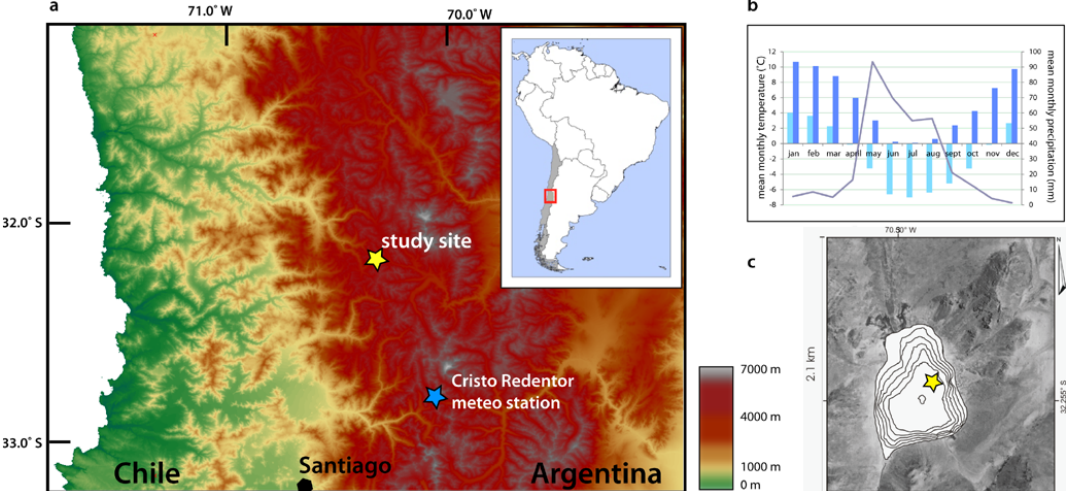
Fig. 1. (a) Overview map of the study area, showing the location of the study area in the high central Andes of Chile and the location of the nearest high-altitude meteorological station Cristo Redentor. (b) Annual distribution of monthly mean precipitation and temperatures. The dark blue bars represent mean monthly values from the reanalysis data (Mitchell and Jones, 2005; AD1901–2006) for the 0 . 5 × 0 . 5 ◦ C gridcell representing Laguna Chepical, whereas light blue bars show monthly means between AD1940–1982 from the Cristo Redentor meteorological station (3109ma.s.l.). The offset is likely due to the on average lower altitudes of the reanalysis grid cell. Precipitation falls almost exclusively during the winter months, at high altitudes in the form of snow. (c) Lake bathymetry and coring location of the cores CHEP 06/03 and